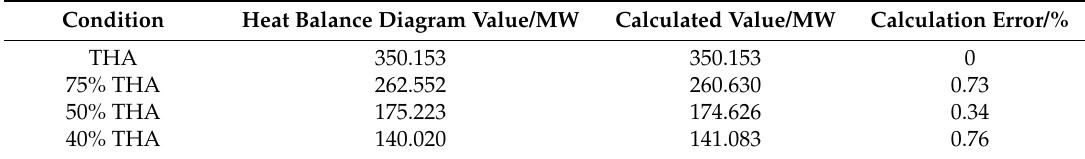
Table 1. Calculation error of power generation under different conditions.